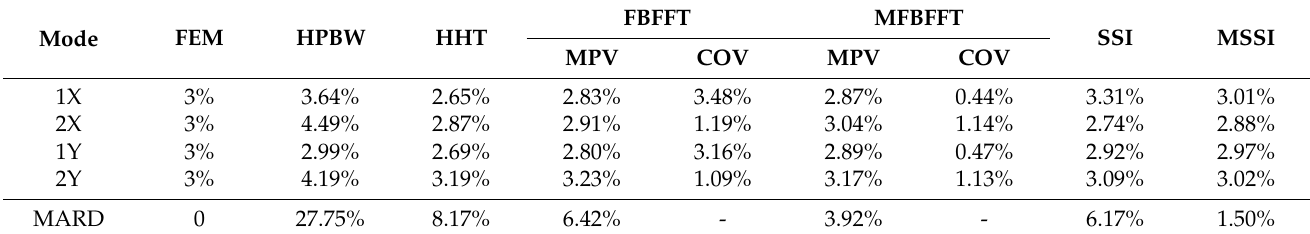
Table 2. The identified damping ratio of four sway modes for a numerical model of the